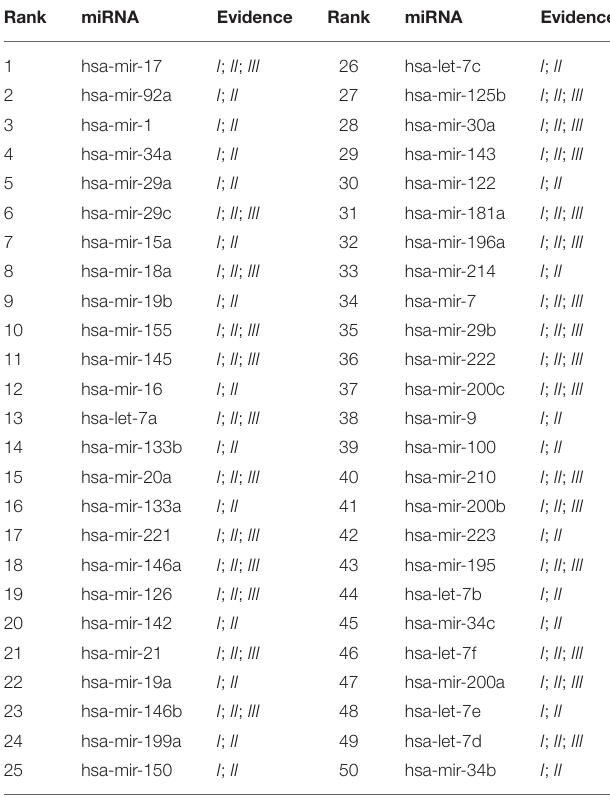
TABLE 3 | The AUCs comparison with other state-of-the-art methods under five-fold CV based on HMDD v2.0. Models